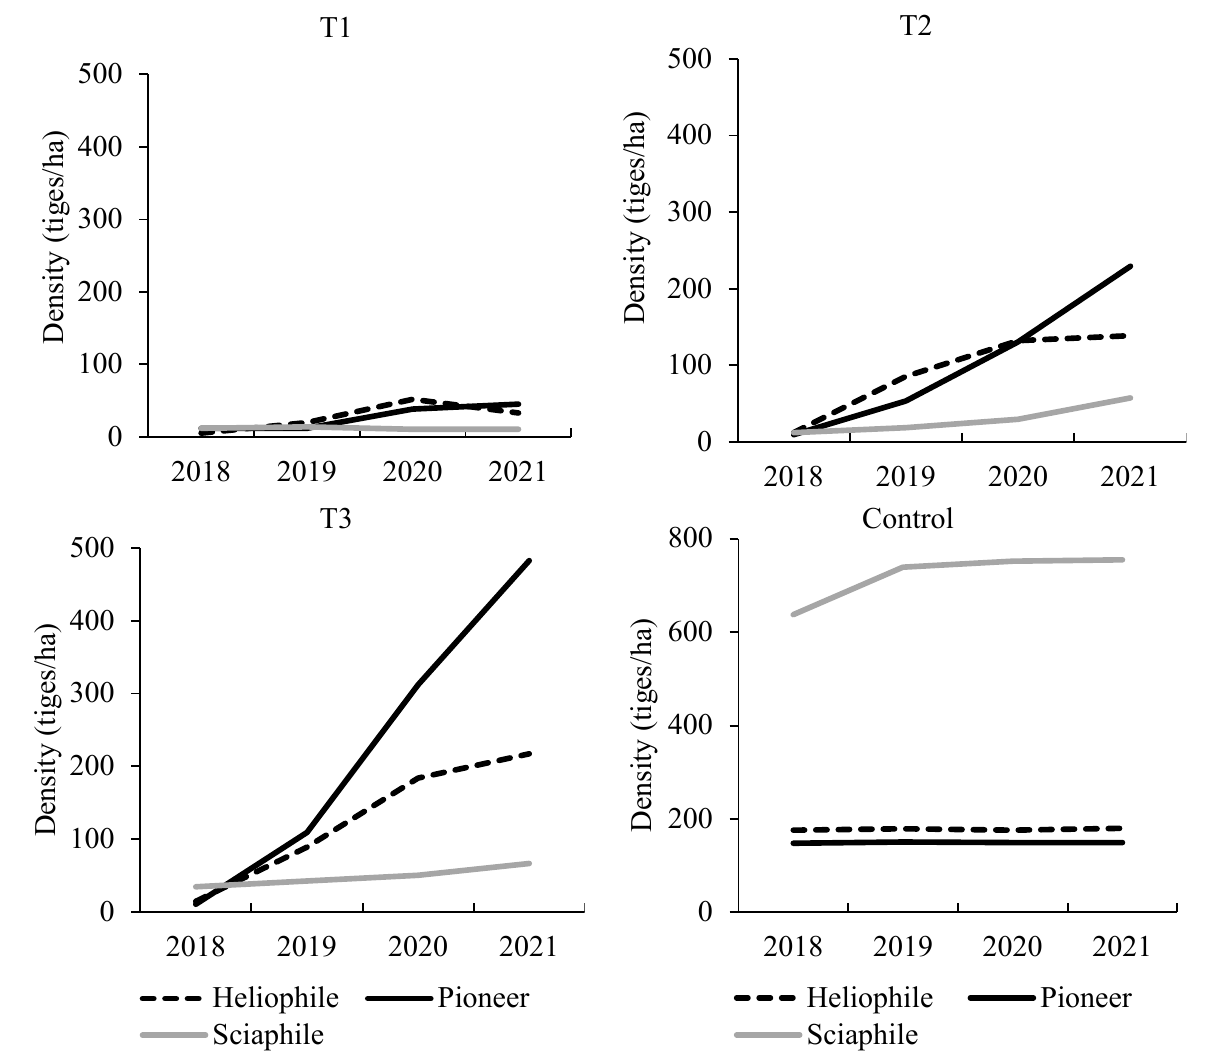
Figure 3. Evolution of the average tree density by treatment. T1 = cocoa plantations which were regularly maintained and exploited, T2 = cocoa plantations which were not maintained but exploited, T3 = cocoa plantations without activities, and Control = a forest relic.